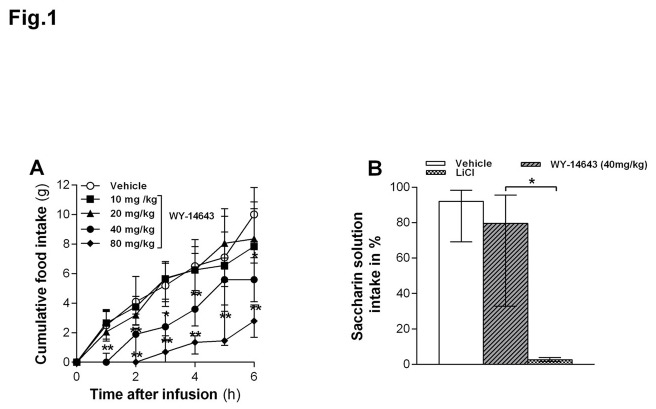
Effect of intraperitoneally (IP) injected Wy-14643 on food intake.(A) IP injected Wy-14643 (10, 20, 40 or 80 mg/kg/ml) dose-dependently reduced cumulative food intake (FI) in ad libitum HFD-fed rats (n=23). * Less than vehicle (P < 0.05), ** less than vehicle (P < 0.01), Mann-Whitney U test. (B) IP administered Wy-14643 (40 mg/kg/ml, n=10) did not reduce saccharin solution intake (% of total fluid intake) vs. water in a two-bottle preference test, whereas LiCl (60 mg/kg in 9.4 ml/kg H2O, n = 3) did. The height of each bar represents the median and the top and bottom of each bar shows 75th and 25th percentile respectively. * Significantly different from vehicle (P = 0.05).